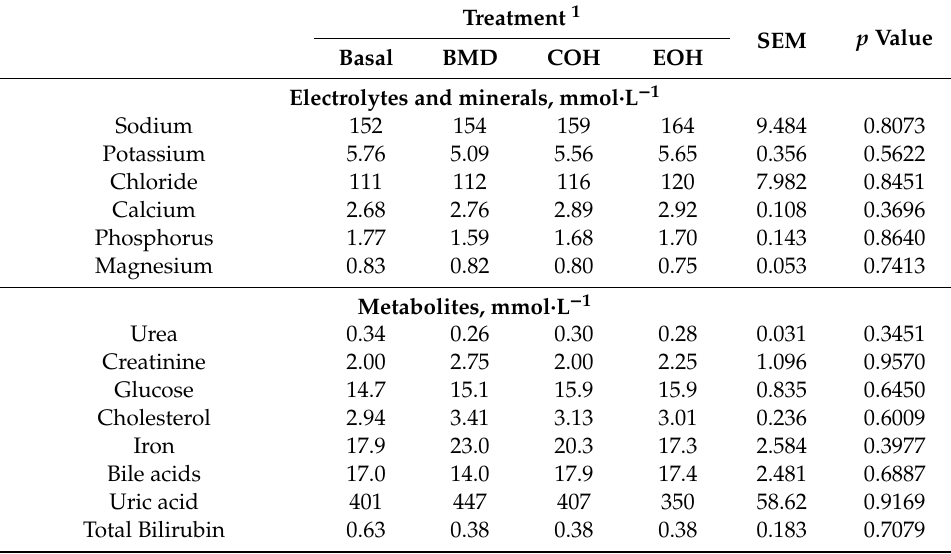
Table 6. E ff ect of dietary supplementation with coarse or extruded oat hulls on blood biochemical characteristics of broiler